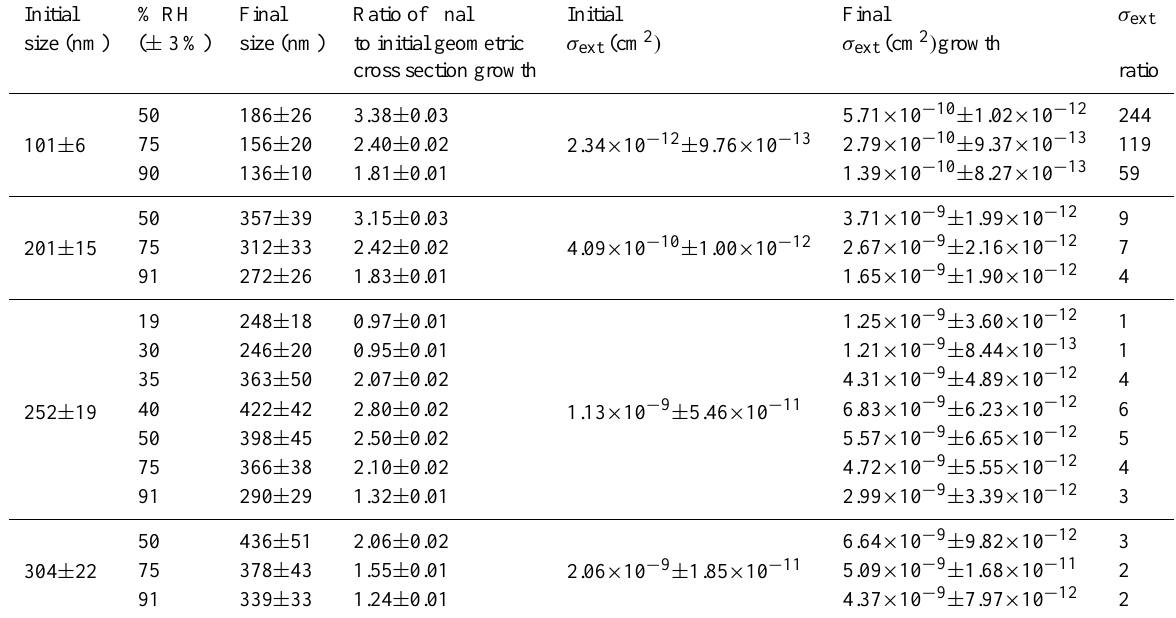
Table 1. The final sizes and optical cross sections compared to the initial values, for AS particles with mean diameters of 101nm, 201nm, 252nm and 304nm, measured by the SMPS, and the growth ratios of the geometric and optical cross sections for all measured RH values.